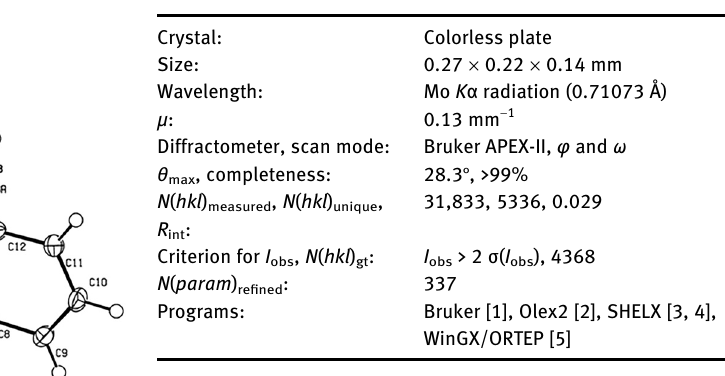
Table  : Data collection and